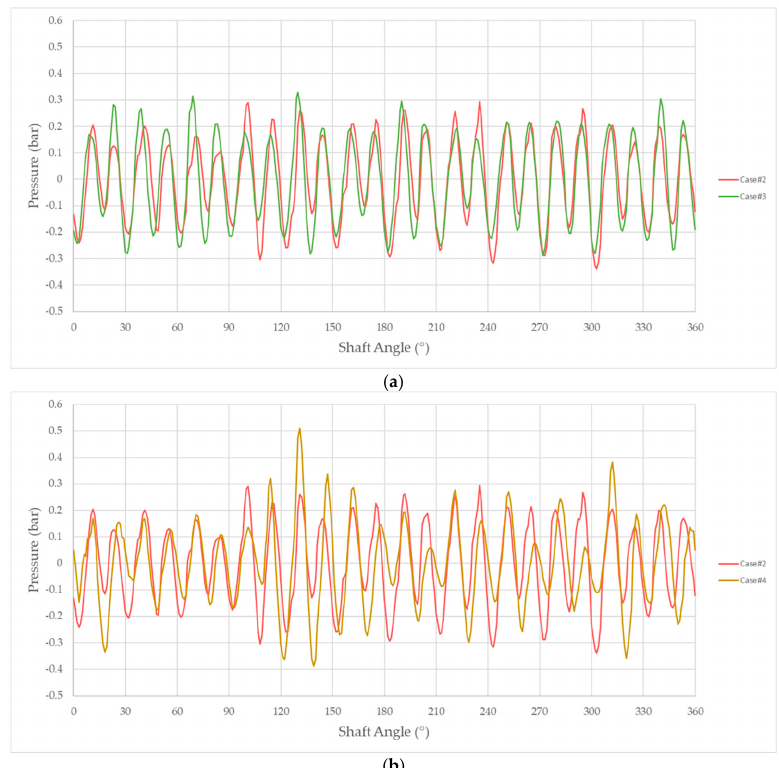
Figure 20. Intake pressure ripple: ( a ) Case #2 and Case #3; ( b ) Case #2 and Case #4. Energies 2021 , 14 , x FOR PEER REVIEW